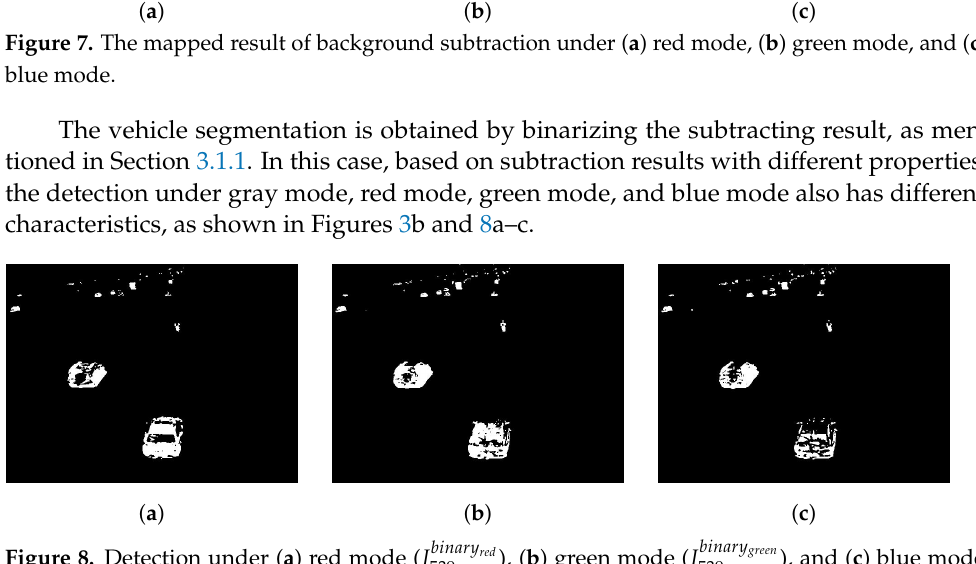
), ( b ) green mode ( I 539